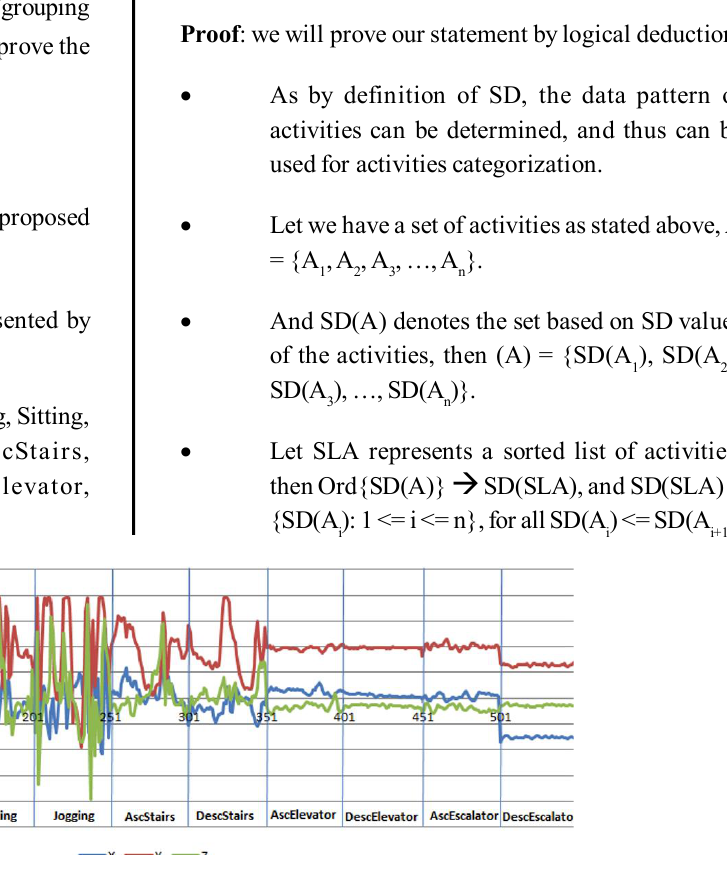
FIG. 4. DATA BEHAVIOR/PATTERN OF VARIOUS